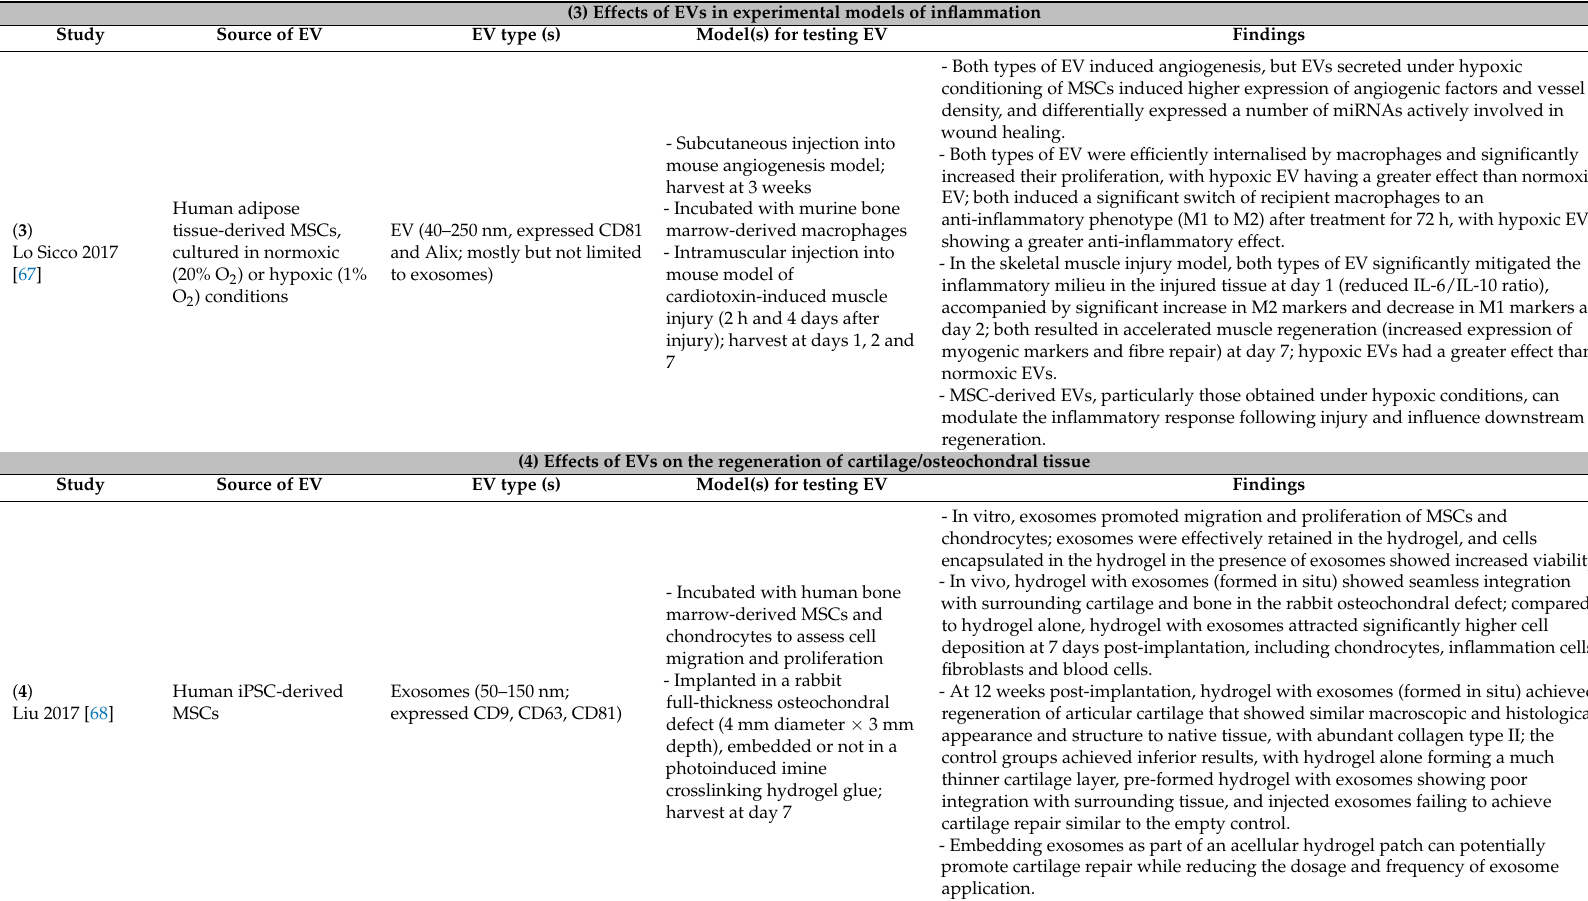
(3) Effects of EVs in experimental models of inflammation